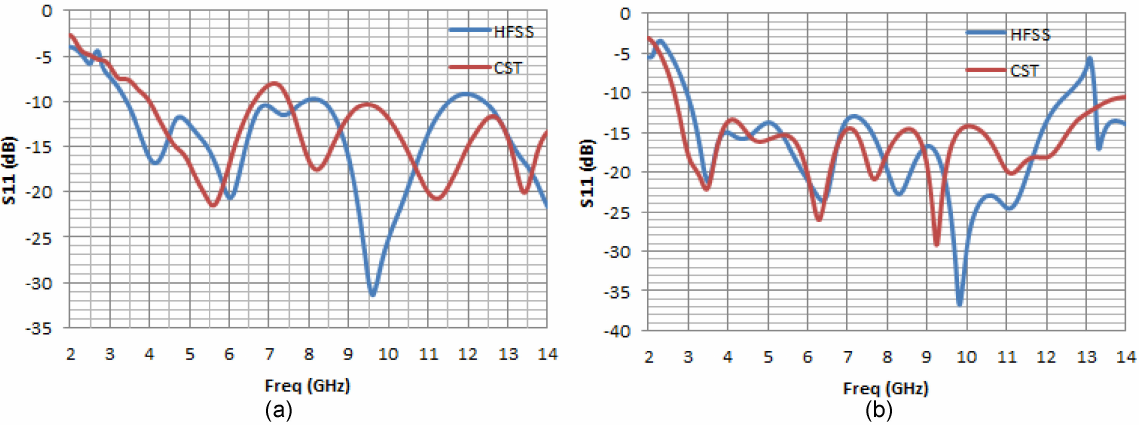
Figure 14. MIMO − UWB antenna S − parameter (S 11 ) using HFSS and CST software ( a ) with MEBG, ( b ) without